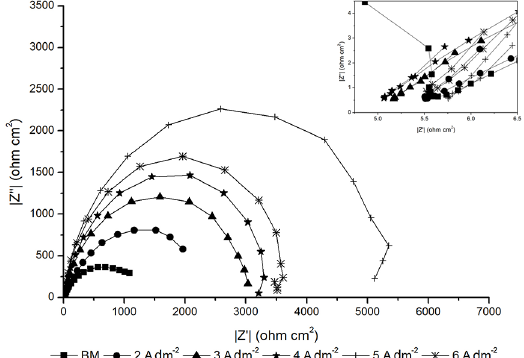
Figura 7. Nyquist diagrams of Co-Ni/SiC coatings and base metal in a 3.5 wt.% NaCl solution.